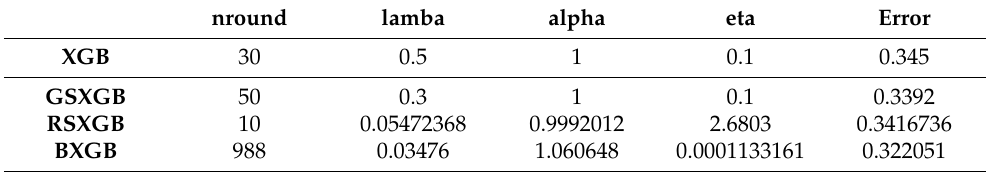
Figure 6. Optimisation of the extreme gradient-boosting model parameters based on Bayesian hyperparameter optimisation results. Table 2. Optimised parameters based on three hyperparameter